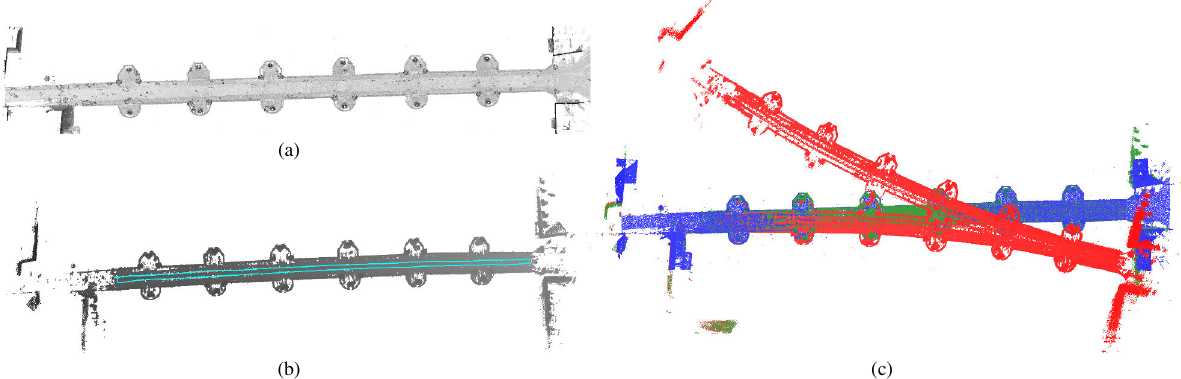
Figure 9. Topview of ”The Bridge”. 9(a) Ground truth only showing the bridge, not the surroundings. 9(b) Final trajectory, created with the continuous-time SLAM. 9(c) Reference data (blue) with overlaid initial (red) and final (green) RADLER point cloud.